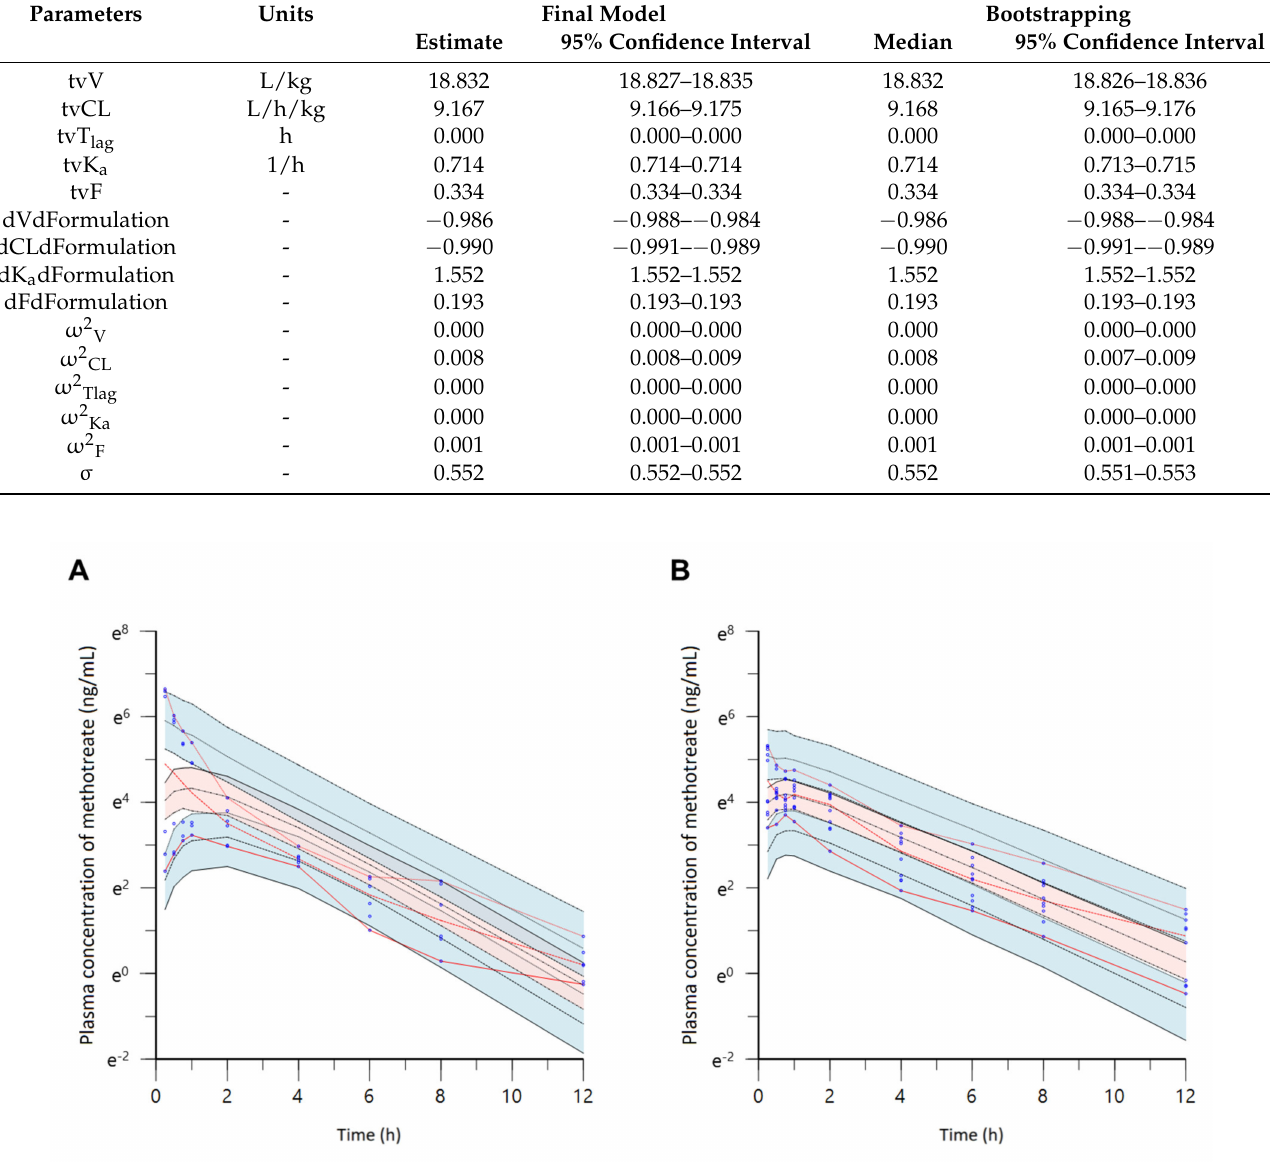
Figure 9. Visual predictive check of the final model for methotrexate-loaded nanoparticles ( A ) and nanoemulsions ( B ). Observed concentrations are depicted by dots. Black dashed lines indicate the 95th, 50th, and 5th percentiles of predicted concentrations. Blue shaded regions (with black boundary lines) indicate 95% confidence intervals for the predicted 5th and 95th percentiles. Red shaded regions indicate 95% confidence intervals for the predicted 50th percentiles. Red lines indicate the 95th, 50th, and 5th percentiles of observed